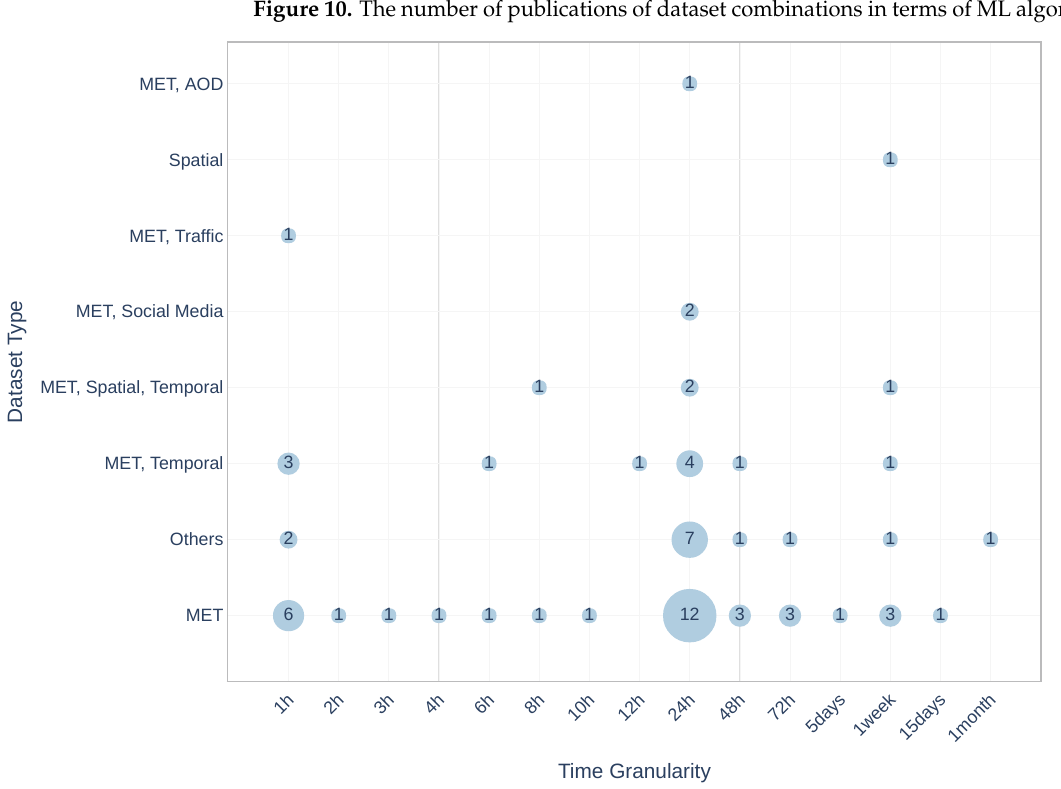
Figure 11. The number of publications of dataset combinations in terms of time